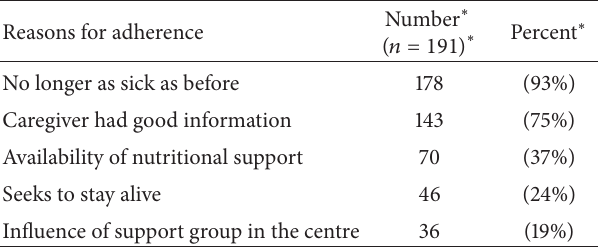
Table 2: Reasons given by patients/caregivers for good adherence. Reasons for adherence